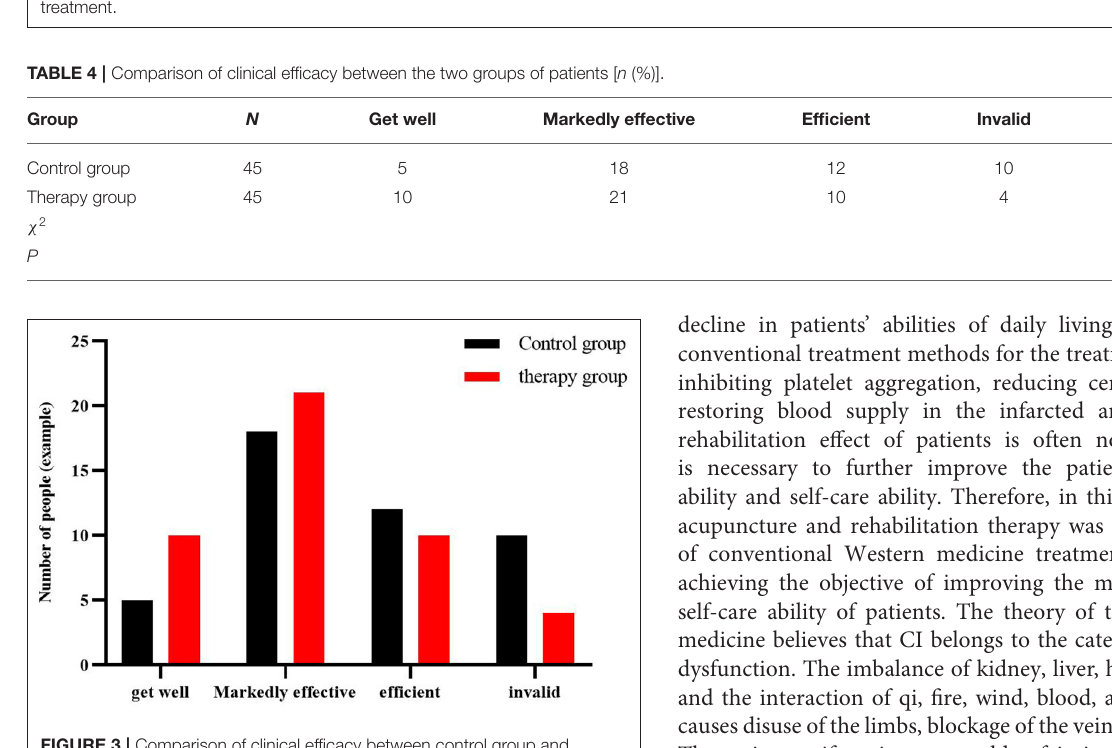
FIGURE 3 | Comparison of clinical efficacy between control group and therapy group